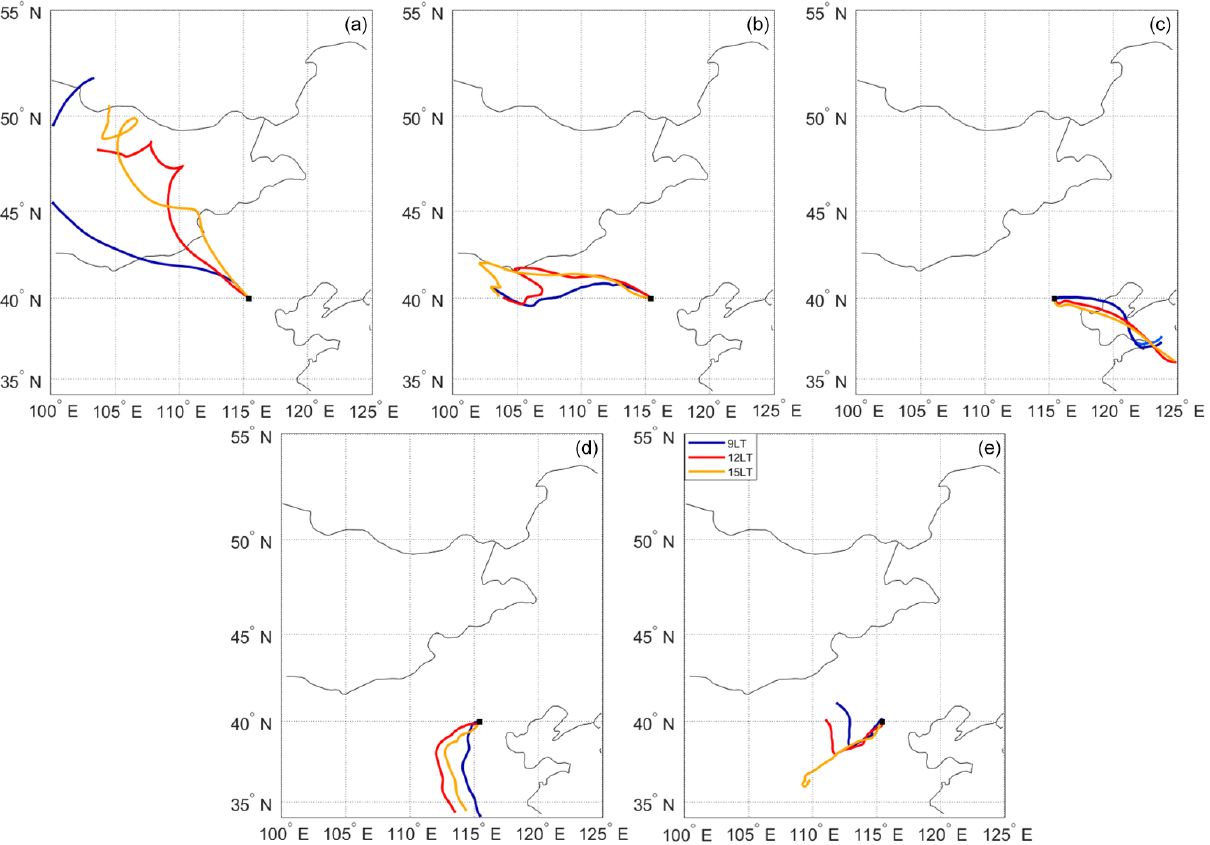
Figure 5. Examples of air masses arrived at both stations from the (a) north group, (b) west group, (c) east group, (d) south group and (d) local group during 09:00–15:00 (local time, LT). Both stations are under the same